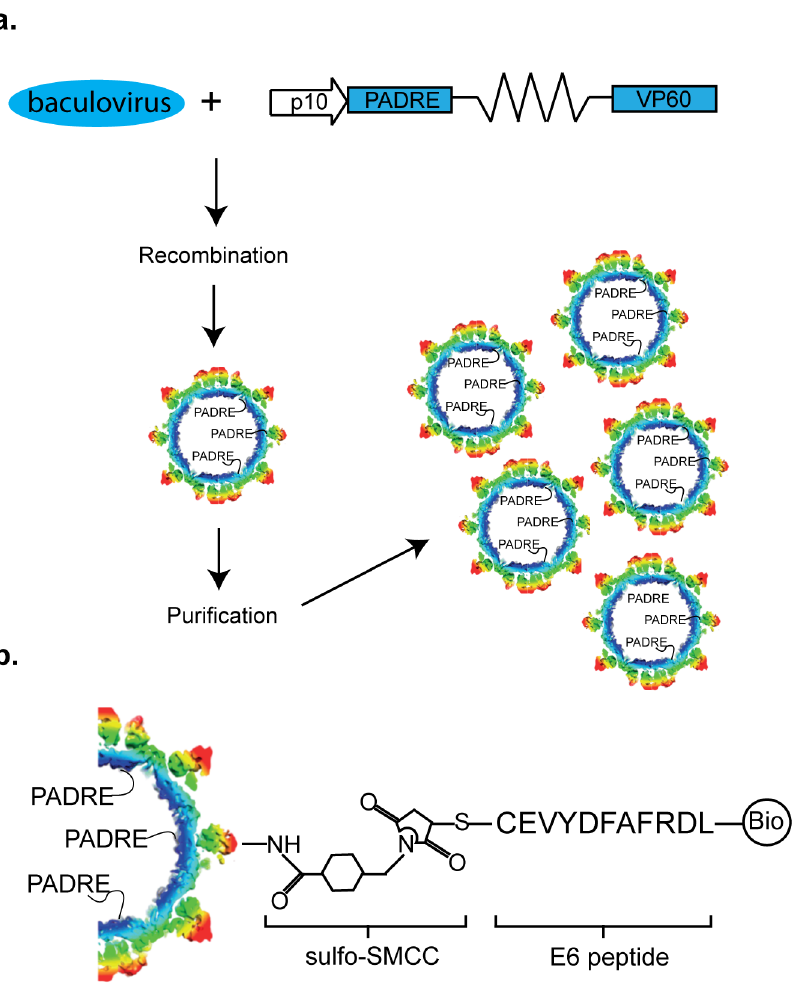
Figure 1. The design and construction of the peptide- and PADRE-modified RHDV-VLP. (a) The VP60 gene modified with a sequence encoding the N-terminal PADRE and flexible linker was recombined into baculovirus in insect cells. Following expression, the RHDV-VLP were purified by CsCl density gradient ultracentrifugation. (b) Diagram of the VLP shell showing the attachment of the PADRE peptide to the internal surface of the VLP by PCR extension and the external attachment of the biotinylated E6 peptide, with the additional N-terminal cysteine, (C-EVYDFAFRDL) by way of a heterobifunctional linker, sulfo-SMCC.